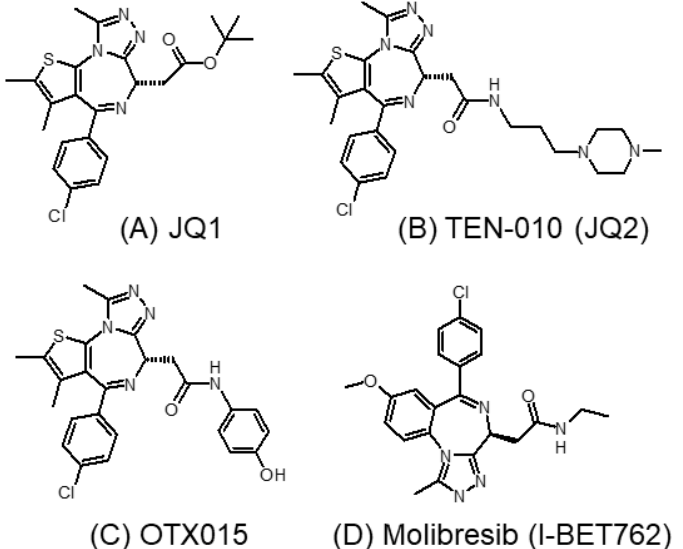
Figure 2. Chemical structures of the pan-BET inhibitors discussed: ( A ) JQ1, ( B ) JQ2, ( C ) OTX015, and ( D ) I-BET762.